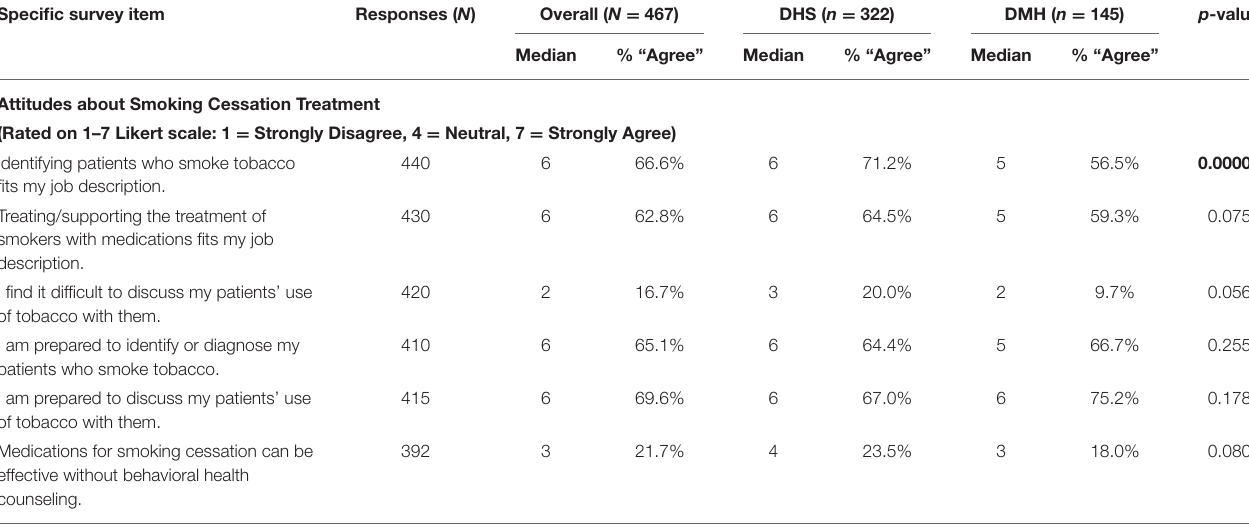
TABLE 1 | Comparing smoking cessation treatment attitudes between DHS and DMH health agency providers.